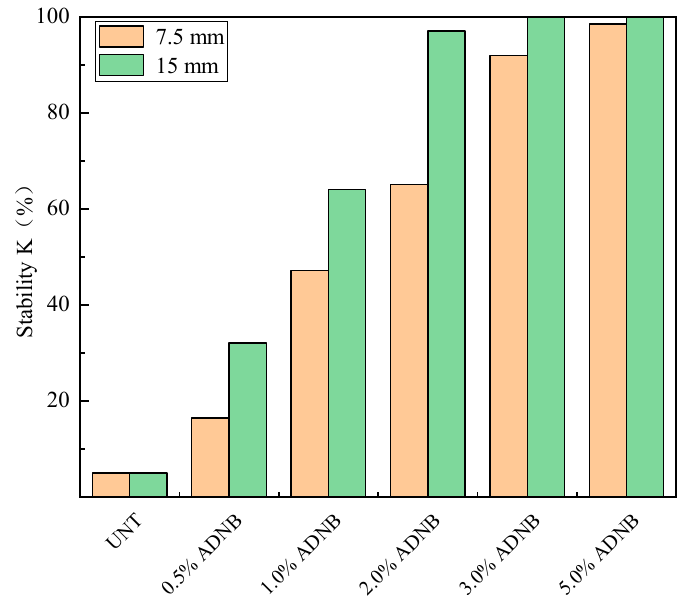
Figure 7. K values of the different aggregates treated with ADNB.